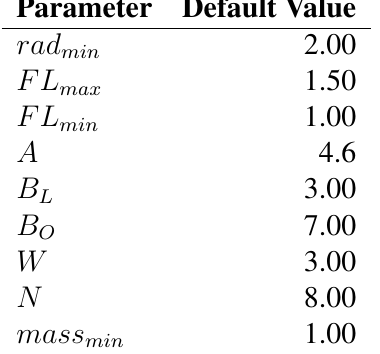
Table 1. Default values for user-defined parameters of the crown segmentation